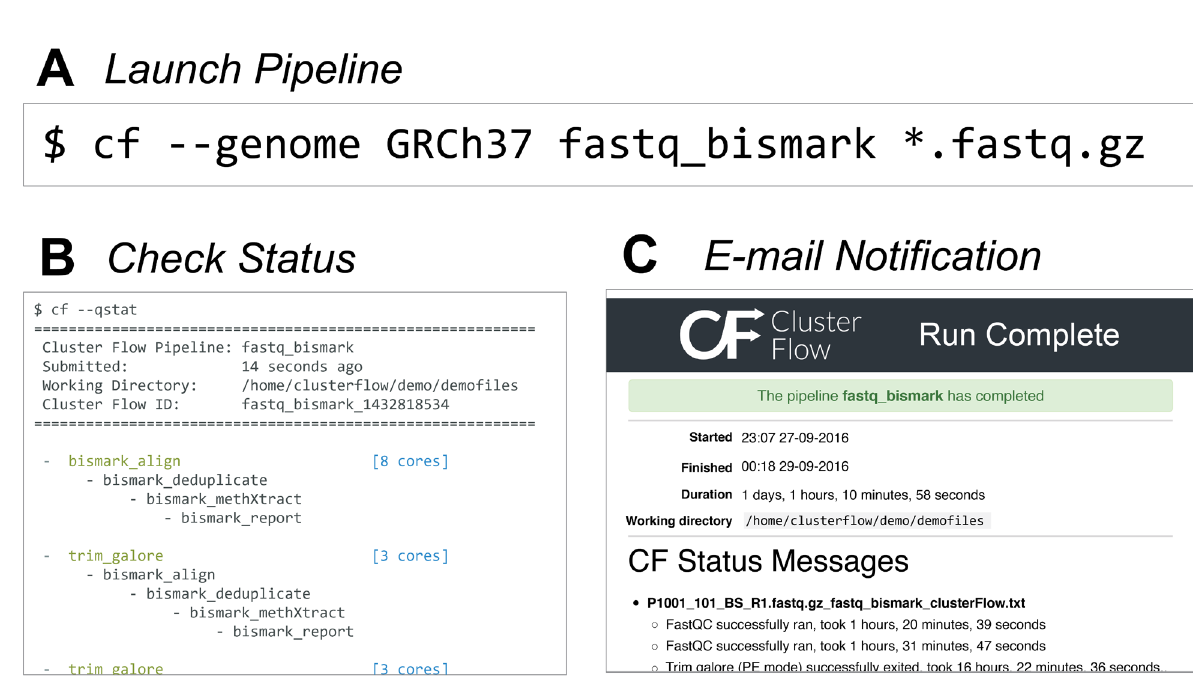
Figure 1. Process for ( A ) Launching an analysis pipeline, ( B ) checking its status on the command line and ( C ) a typical notification